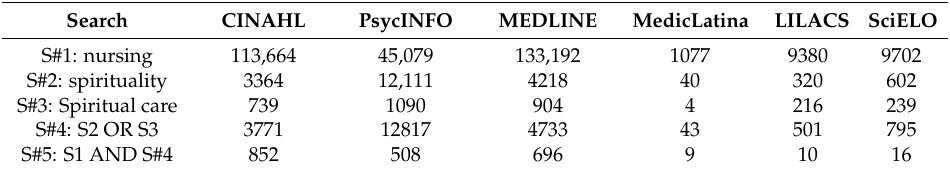
Table 1. Number of citations on the databases search.